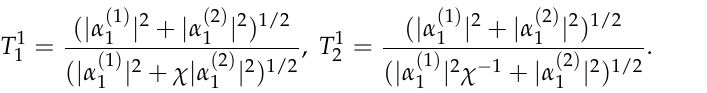
( 1 ) = 0.8 + 0.8 i , α ( 2 ) = 0.6 + 0.6 i , α ( 1 ) = 0.25 + 0.25 i , α ( 2 ) = 1 + i 2 2 1 1